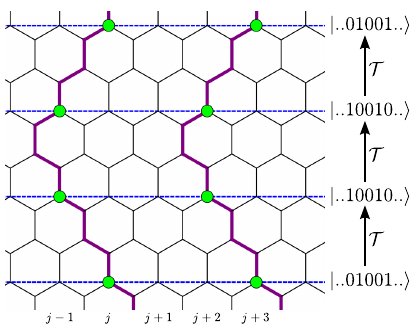
Figure 34: The action of the transfer matrix for the nearest-neighbour TLIAF in a constrained man- ifold. The transfer matrix translates strings (shown in purple) by four honeycomb bonds in the y direction (from one blue dashed line to the next). At each translation the string can follow one of four possible routes, with the result that its x coordinate either remains the same or gets translated one step to the left or right. The string state on one of the blue dashed lines can be specified by the presence (1) or absence (0) of a string at each site on the line. This can be re-interpreted as the presence or absence of a spinless fermion at a particular imaginary timestep in a 1D quantum